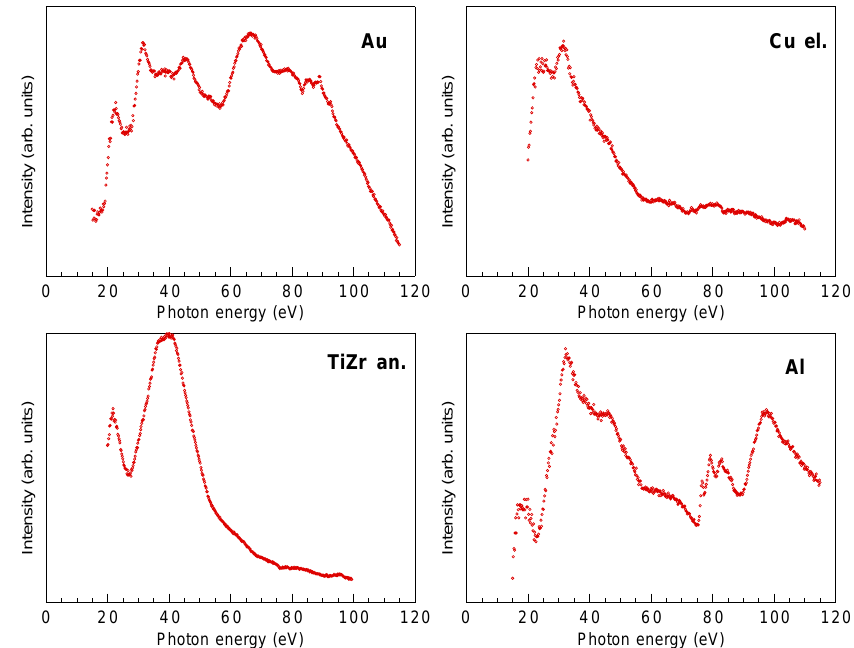
FIG. 12. (Color) The CFS spectra from Au, Cu-el., TiZr-an., and Al in the photon energy range from 18 to 110 eV. The collected electrons are emitted at 1.0 6 0.2 eV kinetic energy.